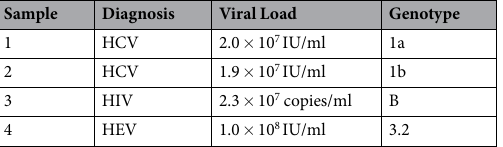
Table 1. Details of the four samples combined to create the Blood Borne Virus Panel. Viral load quantification for the HEV sample was performed in-house 44 , as was genotyping of the HCV 43 and HEV 68 samples. Otherwise, the diagnostic assays were performed by the source laboratory. HCV and HIV viral loads were confirmed using methods from refs 45 and 46